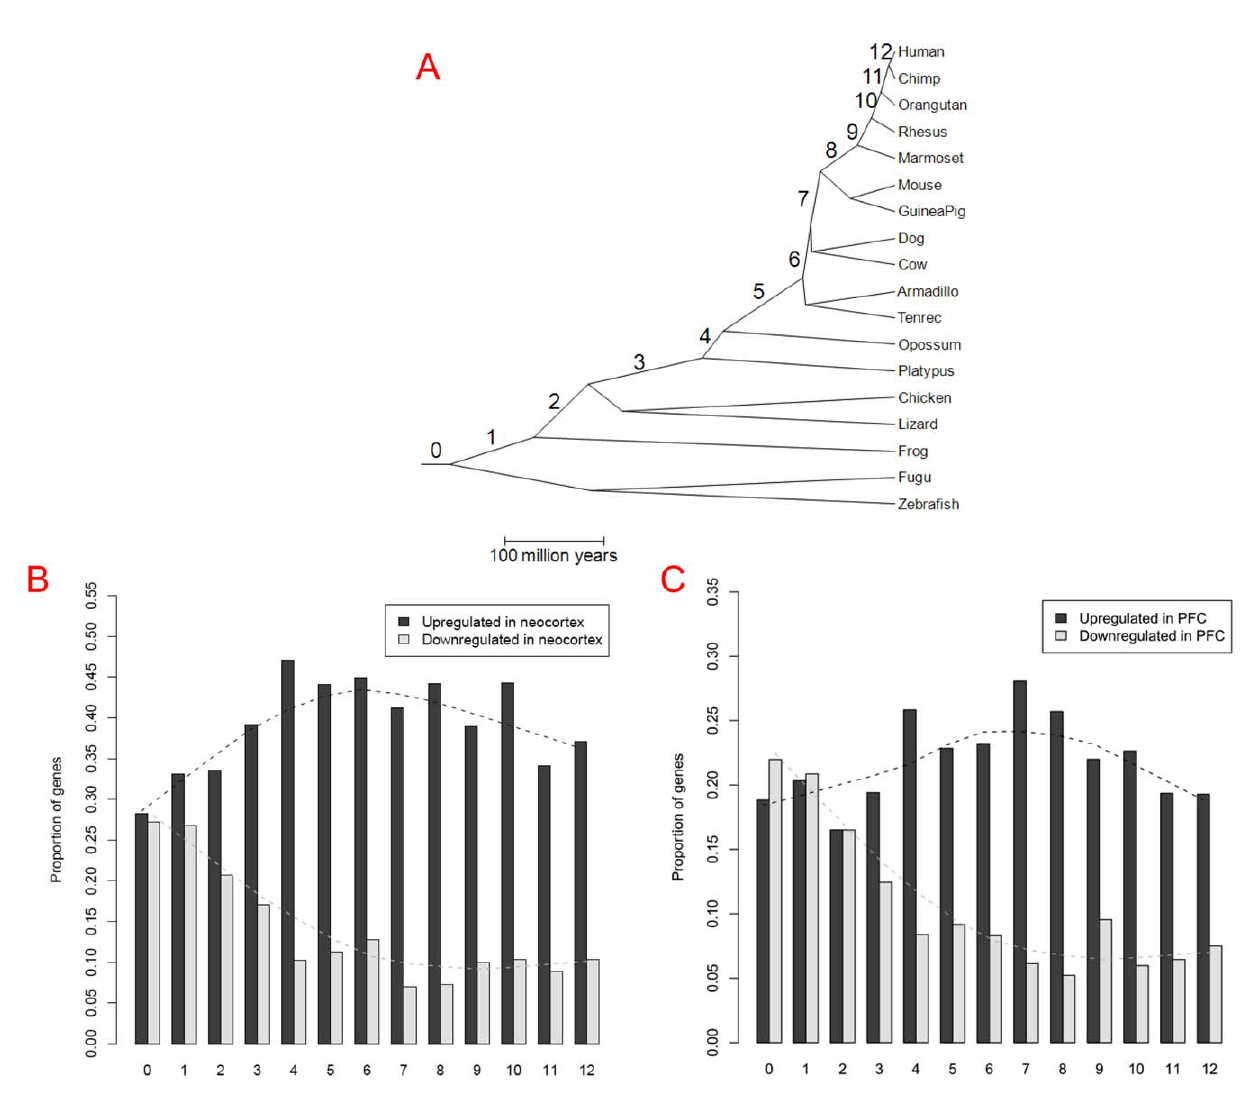
Figure 5. Proportion of genes differentially expressed between neocortex (or PFC) and the non-neocortical regions across different gene ages. (A) The phylogenetic tree together with the branch assignments (0 , 12) follows [19]. 0 indicates the oldest gene group, i.e. genes shared by all vertebrates, and branches 8 , 12 indicate primate-specific genes, with branch 12 the human-specific lineage. (B) Proportion of genes differentially expressed between neocortex and non-neocortical regions, detected by exon arrays for genes originating in each branch. The dashed line shows the trend fit based on the lowess function of R [56]. (C) Genes with differential expression between PFC and non-neocortical control